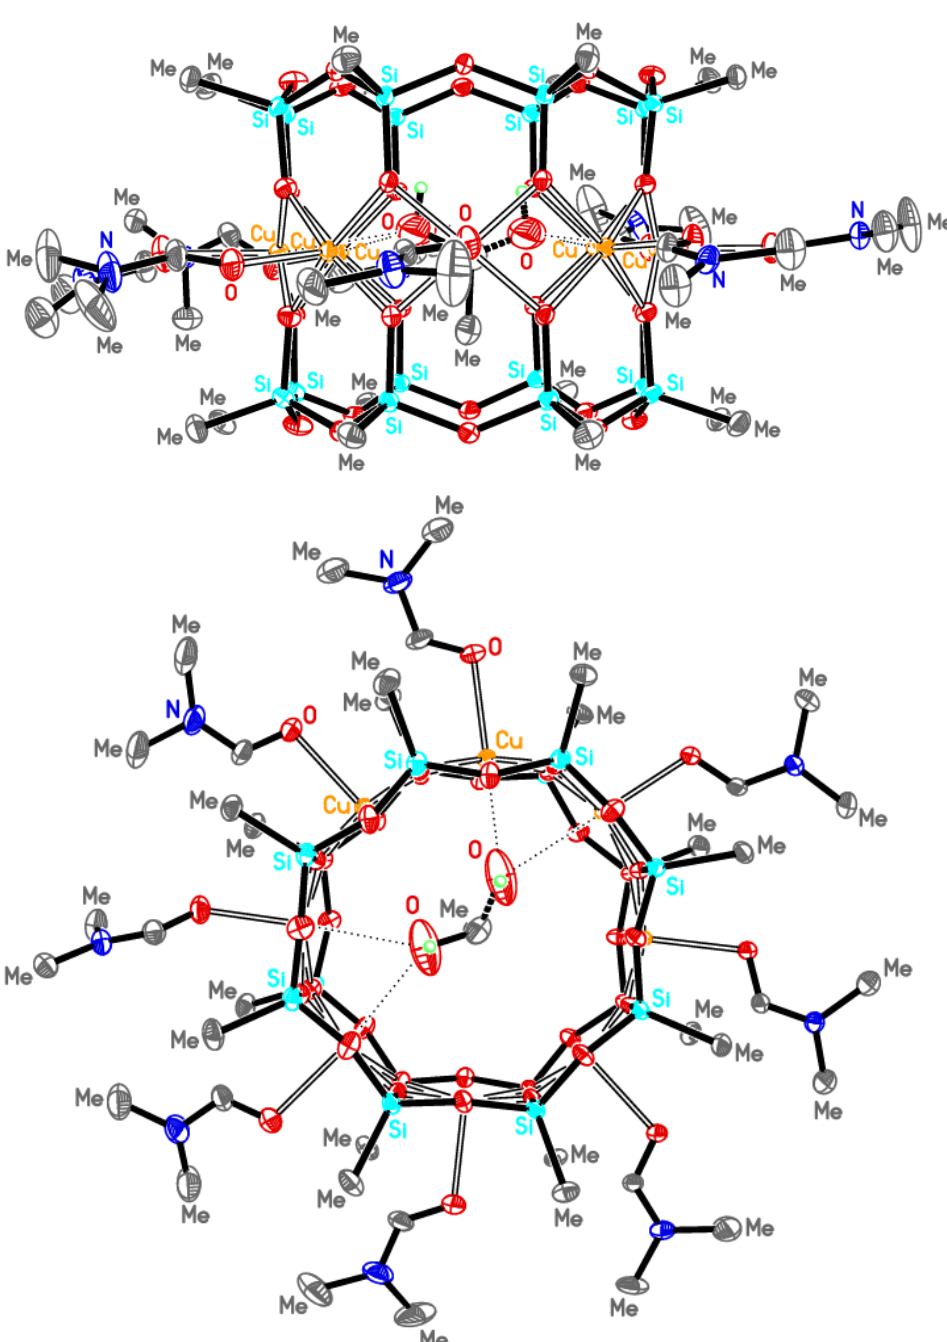
Figure 1. Two projections of molecular structure of complex [(MeSiO 2 ) 8 ] 2 Cu 8 (DMF) 8 (EtOH)] • 2.75 (DMF) • 0.25 (Me 2 CO) 1 ; the solvate dimethylformamide and acetone molecules are not shown. Hydrogen atoms are presented as green dots (the same concerns Figures 2–6).